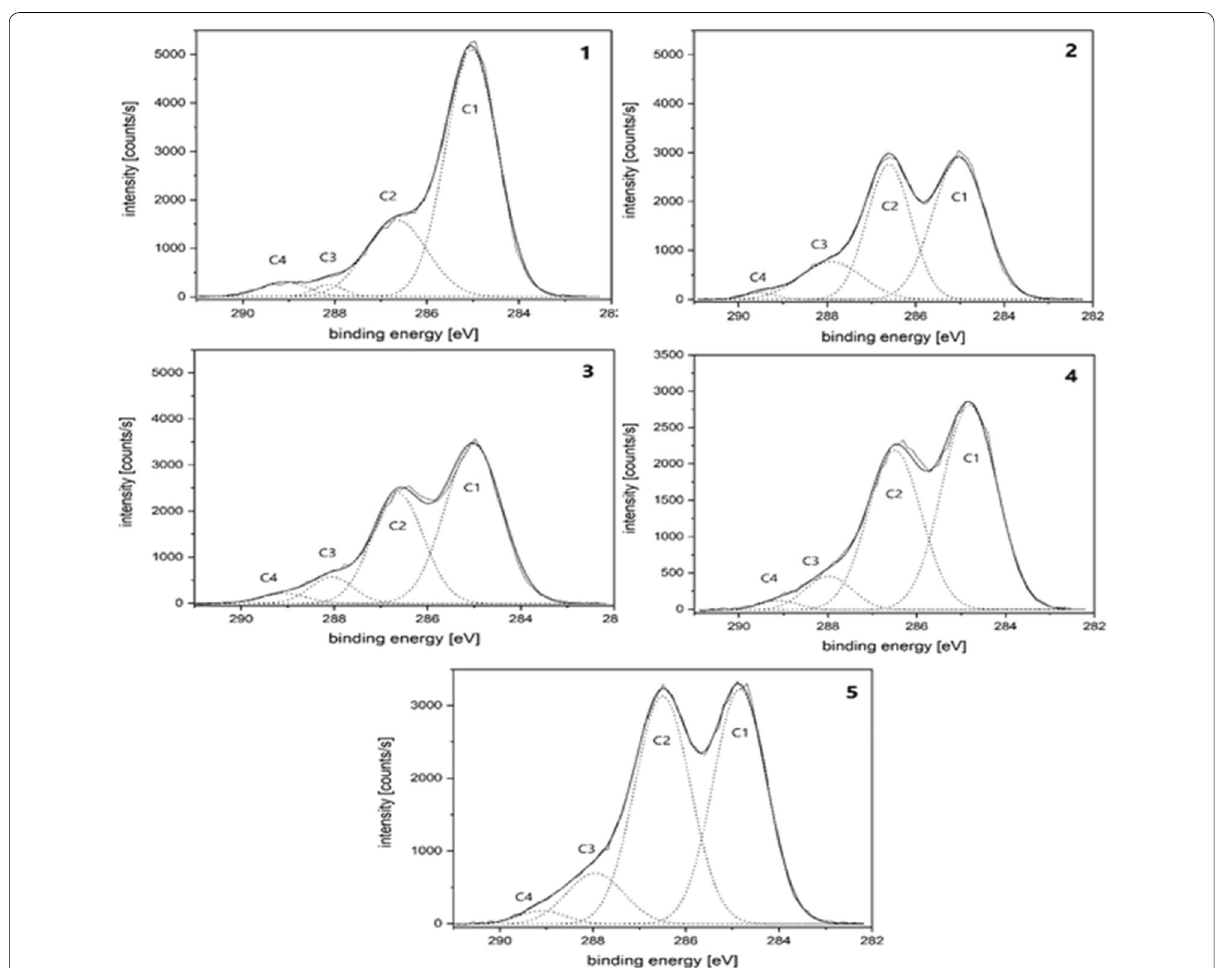
Fig. 3 High-resolution spectra of the C1s energy level of new spruce [ 1 ], aged spruce (a) [ 2 ], aged spruce (b) [ 3 ], new fir [ 4 ] and aged fir [ 5 ]